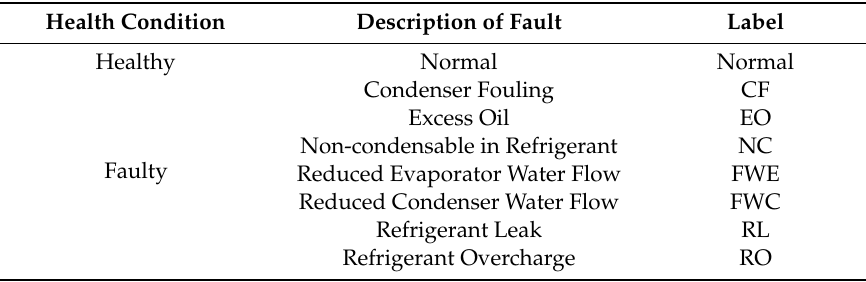
Table 1. Summary of chiller faults.